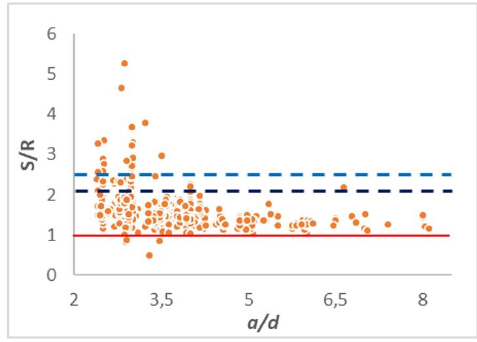
to Frosch et al. [5] 𝑀𝑀 / 𝑑𝑑